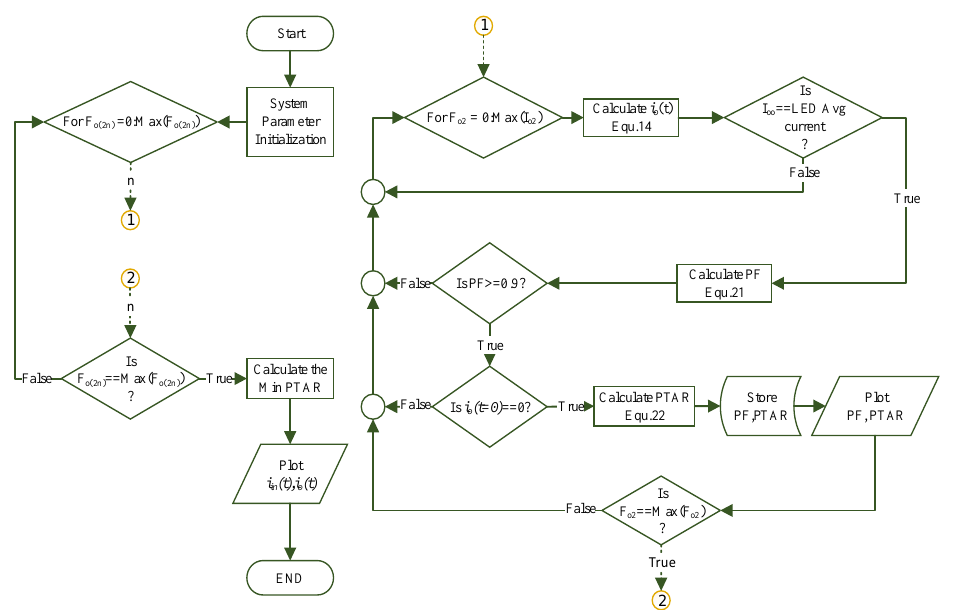
Figure 5. Flow chart of the MATLAB script.